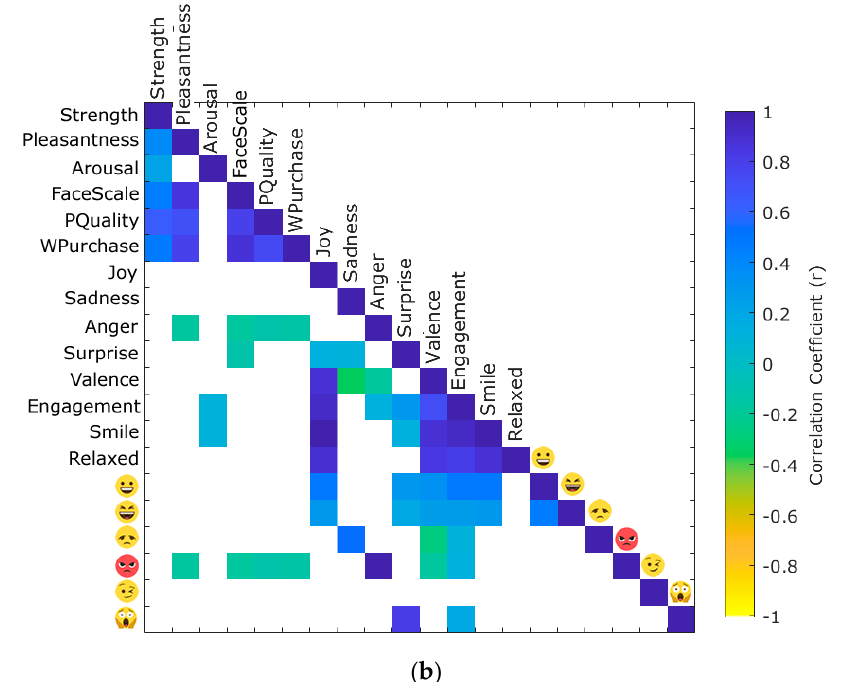
Figure 2. Multivariate data analysis showing ( a ) the multiple factor analysis using all quantitative and frequency data, and ( b ) matrix showing only the significant correlations ( p < 0.05) for the quantitative self-reported and biometric responses. The color bar represents the positive correlations on the blue side and negative on the yellow side. Abbreviations of self-reported responses are shown in Table 1; CATA: check all that apply; AOI: area of interest; F1 and F2: factors one and two, respectively.